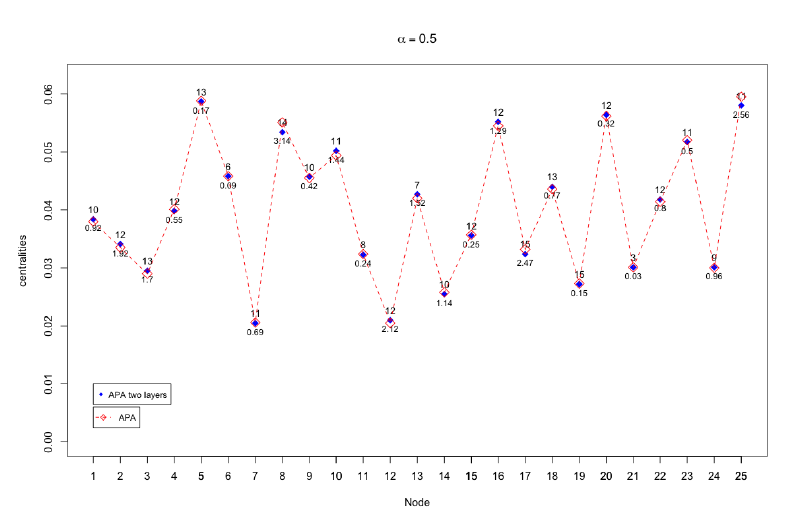
Figure 4. APA and APA2f centrality for α =